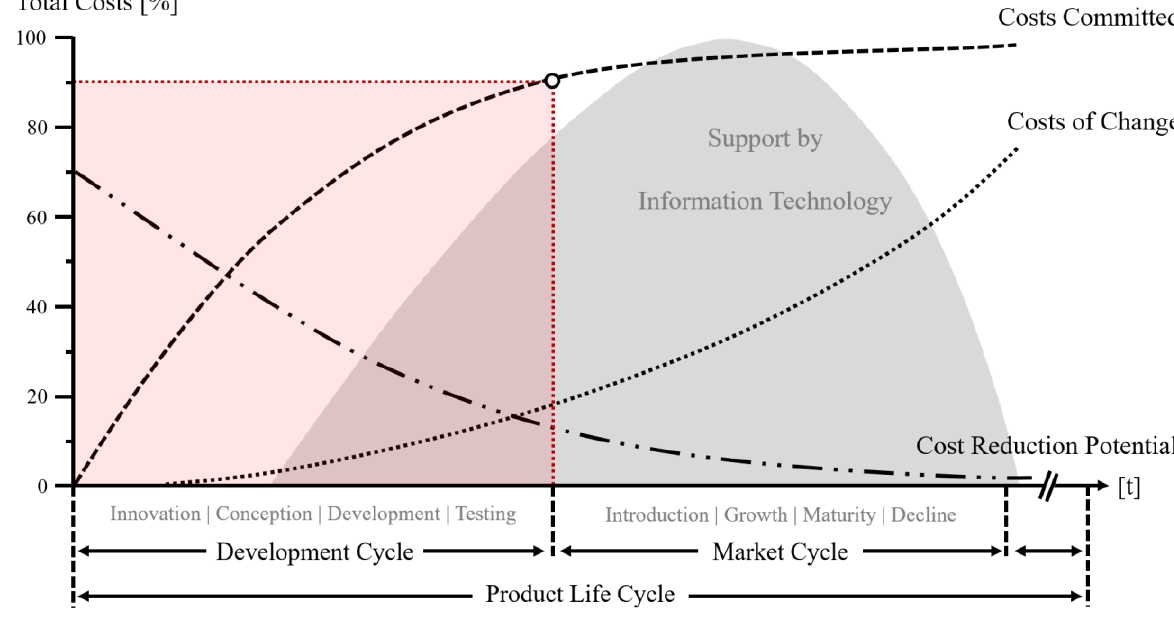
Figure 2. Cost commitments and reduction potential along product life cycle ([15], adapted from